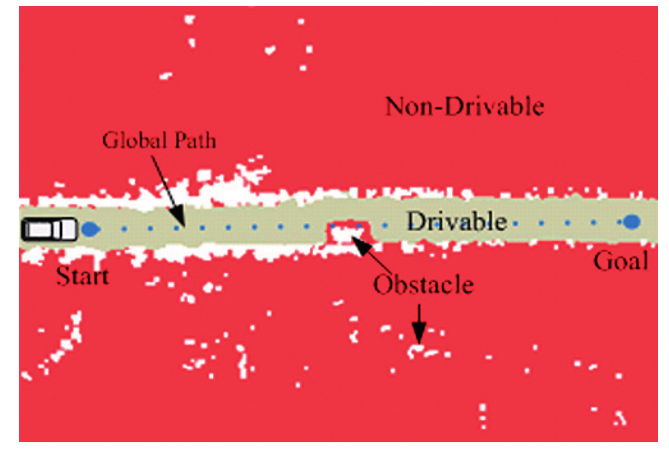
Figure 4. The drivability grid